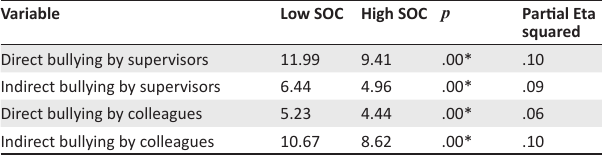
TABLE 10: Analysis of variance – differences in workplace bullying based on sense of coherence.